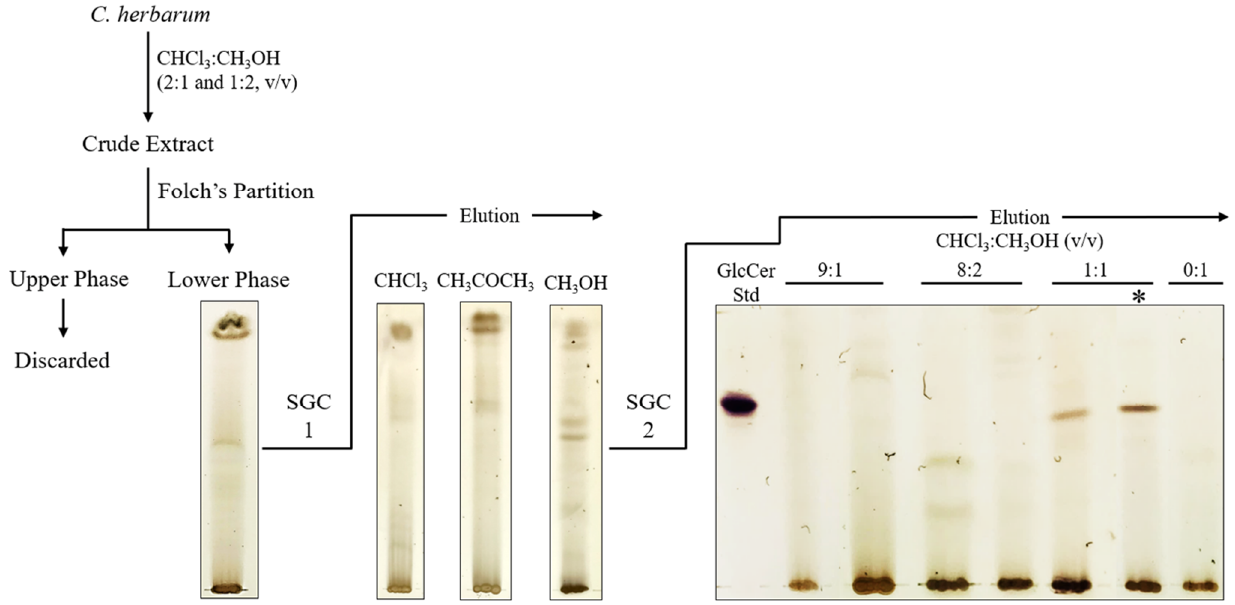
Figure 1. Scheme of the isolation and purification of glycosphingolipid from C. herbarum . High performance thin layer chromatography (HPTLC) of fungal neutral glycosphingolipids isolated by silica gel column chromatography (SGC). Solvent system for SGC 1: CHCl 3 , CH 3 COCH 3 and CH 3 OH; for SGC 2: CHCl 3 :CH 3 OH (9:1; 8:2; 1:1 and 0:1 v / v ). Running solvent for HPTLC–chloroform/methanol 2 M NH 4 OH (40:10:1 v / v / v ). Detection: iodine and orcinol–sulfuric acid reagents. * Purified